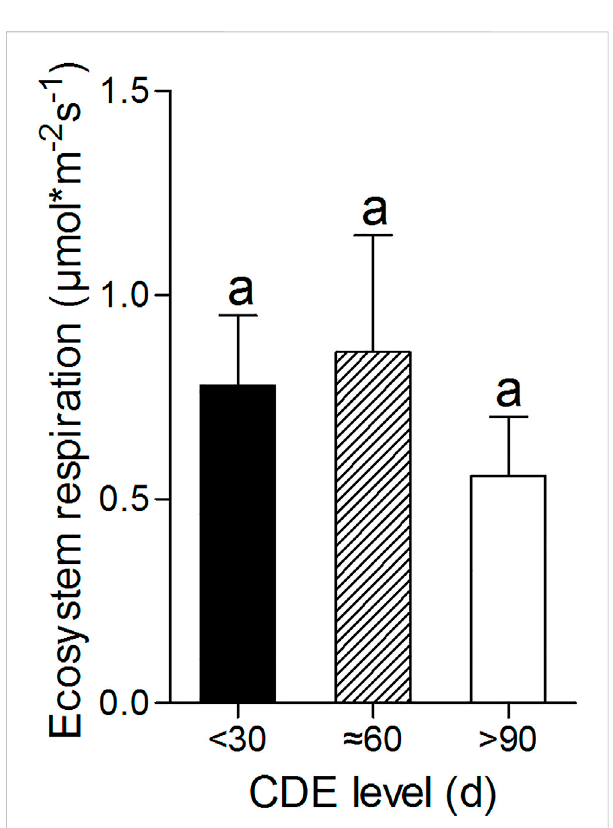
FIGURE 5 The differences of ecosystem respiration among different CDE levels.Thevaluesof fl uxeswiththesamelowercaseletterdonotdiffer signi fi cantly ( p > 0.05) based on Dunn ’ s multiple comparison test.